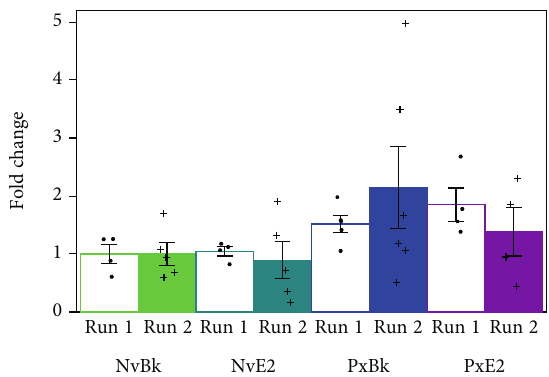
Figure 2: All data for Bdnf exon IV transcription in AC from two runs with independent samples. Fold change data from both independent qRT-PCR runs of AC samples from the 4 animal groups where pup experience and hormones were manipulated. Error bars here and in subsequent fi gures represent mean ± standard